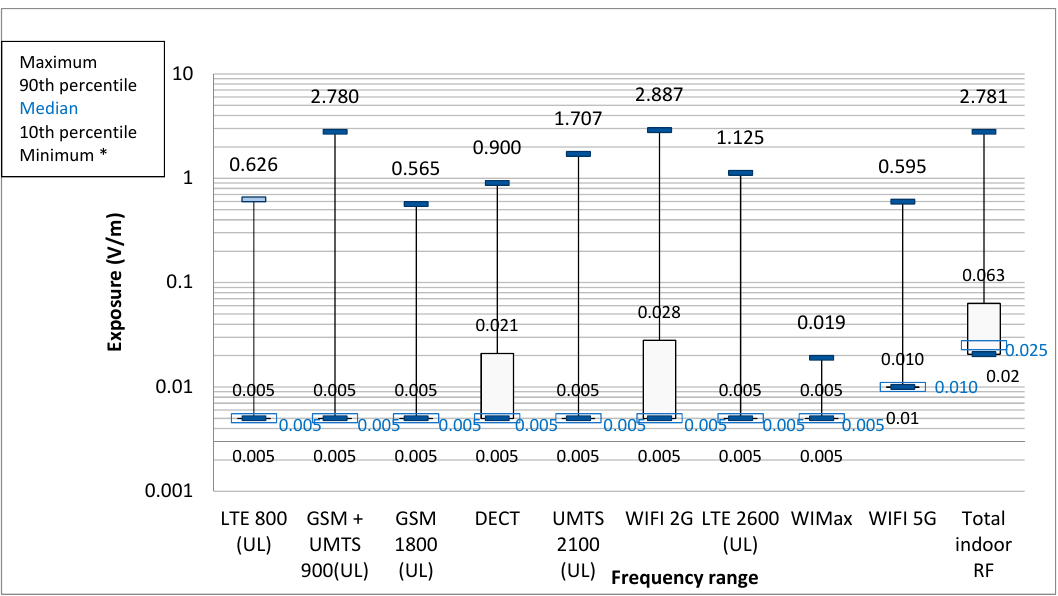
Figure 1. Exposure due to indoor sources. * Minimum is equal to the detection threshold of 0.01 V/m for the Wifi, and 0.005 V/m for other frequencies. The value of the minimum is not specified in the graph.